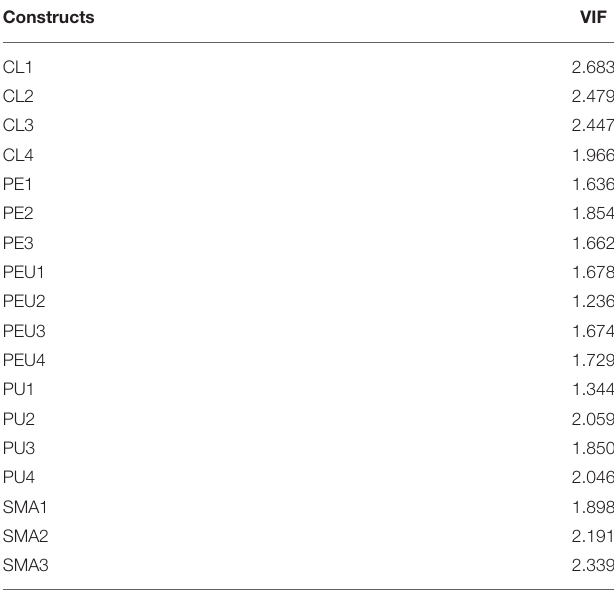
TABLE 5 | Standard assessment criteria of a structure